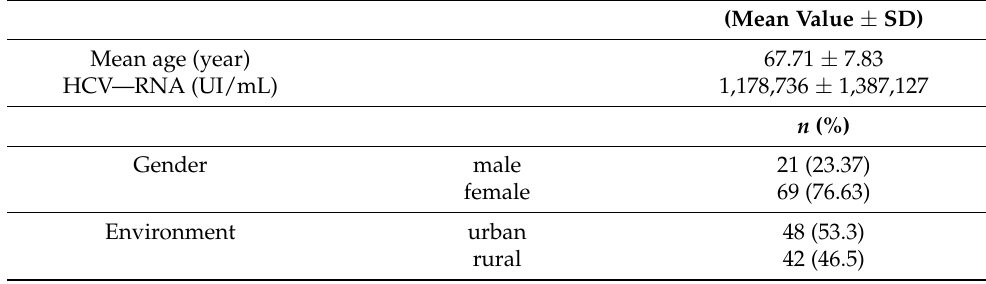
Table 1. Demographic data of the study sample.